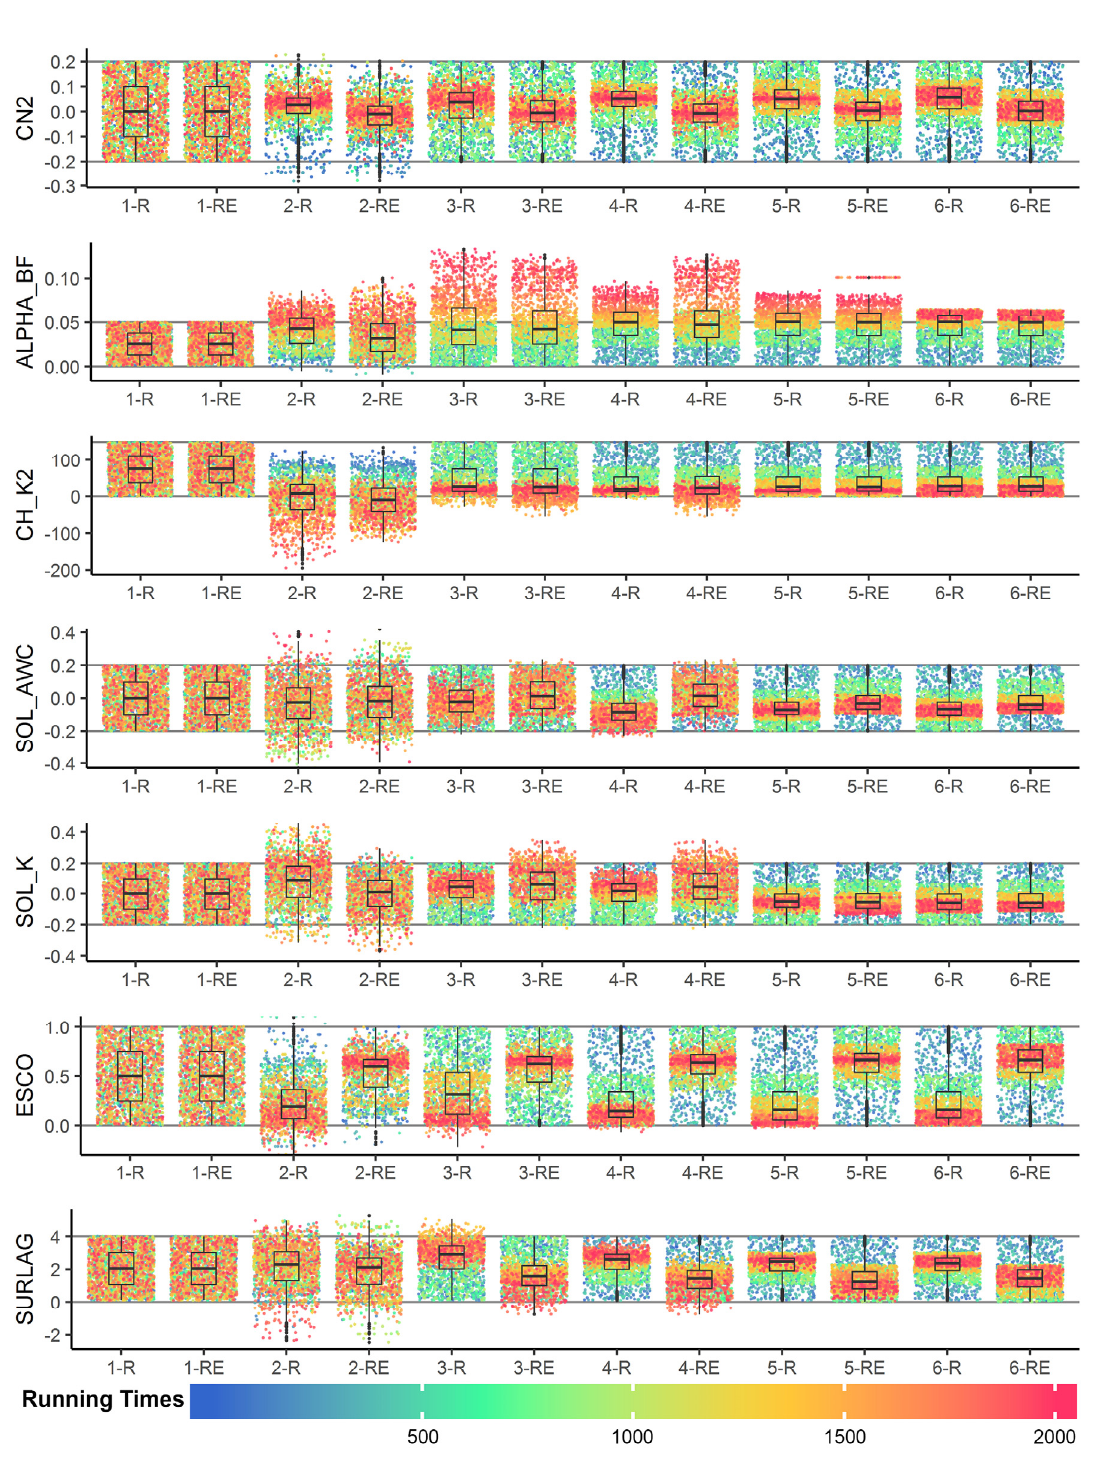
Figure 7. Uncertainty ranges of calibrated parameters using different methods and running times during the calibration period. The back line in each panel indicates the initial range of the parameters (listed in Table 1). The definition of scenario codes (e.g., 1-R, 1-RE, etc.) on X axis can be referenced to Table 2.